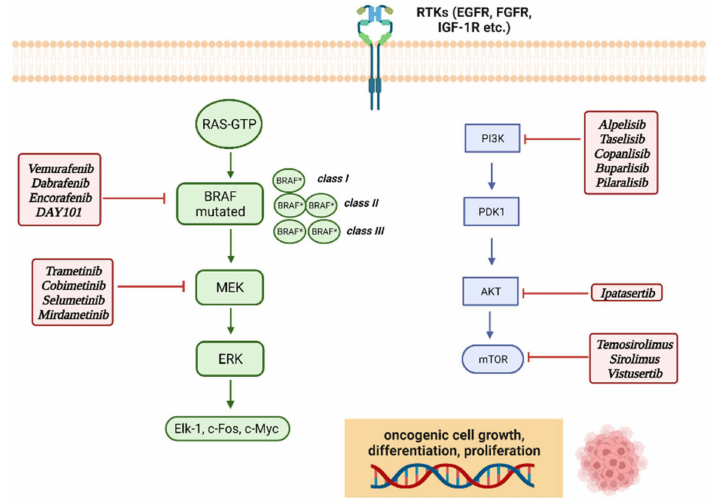
Figure 3. RTKs: receptor tyrosine kinases; EGFR: epidermal growth factor receptor; FGFR: fibroblast growth factor receptor; IGF-R1: insulin-like growth factor 1 receptor; RAS: Rat sarcoma (reflecting how the first member of the RAS gene family was discovered); BRAF : v-raf murine sarcoma viral oncogene homolog B1; MEK: mitogen-activated protein kinase; ERK: extracellular signal-regulated kinase; Elk-1: ETS (erythroblast transformation specific) like-1 protein; c-Myc: c-myelocytomatosis oncogene product; PI3K: phosphatidylinositol-3 kinase; PDK1: 3-phosphoinositide-dependent kinase 1; mTOR: mammalian target of rapamycin: BRAF *: mutated BRAF